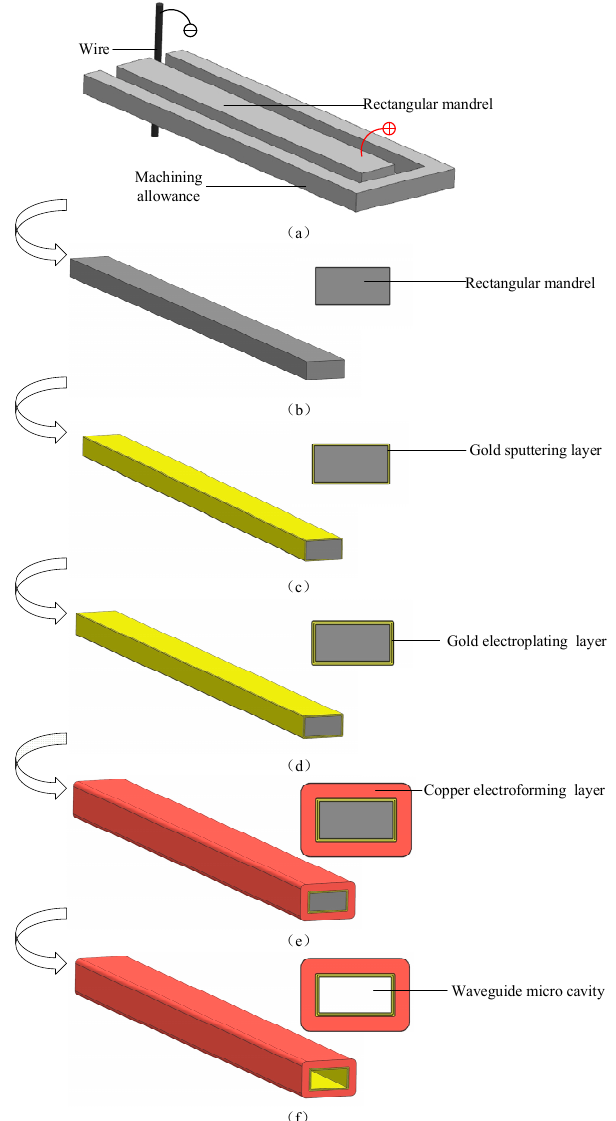
Figure 1. Schematic of the machining process. According to the description of the combination process, the specific end size of the waveguide cavity will be consistent with the rectangular mandrel. Because a rectangular mandrel with an end-face size of hundreds of microns or even tens of microns can be machined through WECMM, the manufacturing of a terahertz micro-metal rectangular waveguide cavity with an end-face size of hundreds of microns or even tens of microns can be realized through this combined manufacturing process; an end-face size of this scale corresponds to that of a terahertz micro-rectangular waveguide cavity in a high- frequency band. In addition, a rectangular mandrel with good dimensional accuracy, surface roughness, and edge radius can be obtained through WECMM. The gold sputtering layer can prevent local oxidation on the surface of the rectangular mandrel, so that it is more uniform and easier to gold-electroplate. When the rectangular mandrel is rapidly chemically dissolved, a waveguide cavity with better dimensional accuracy, inner surface